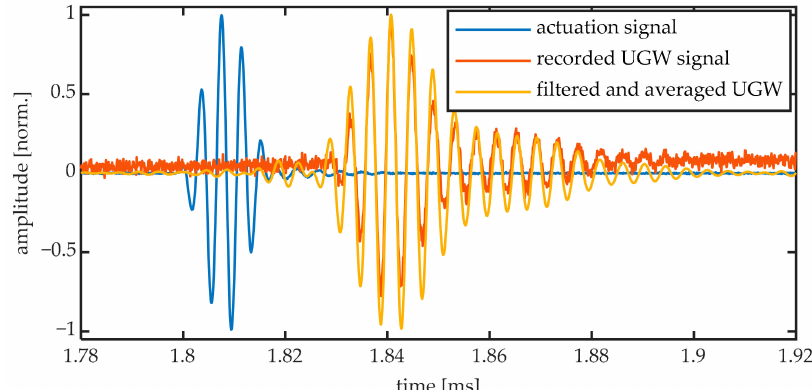
Figure 5. Actuation signal as measured by the oscilloscope, UGW signal as measured by the photodiode and filtered and average UGW signal of a 250 kHz UGW acquired by the 10-mm